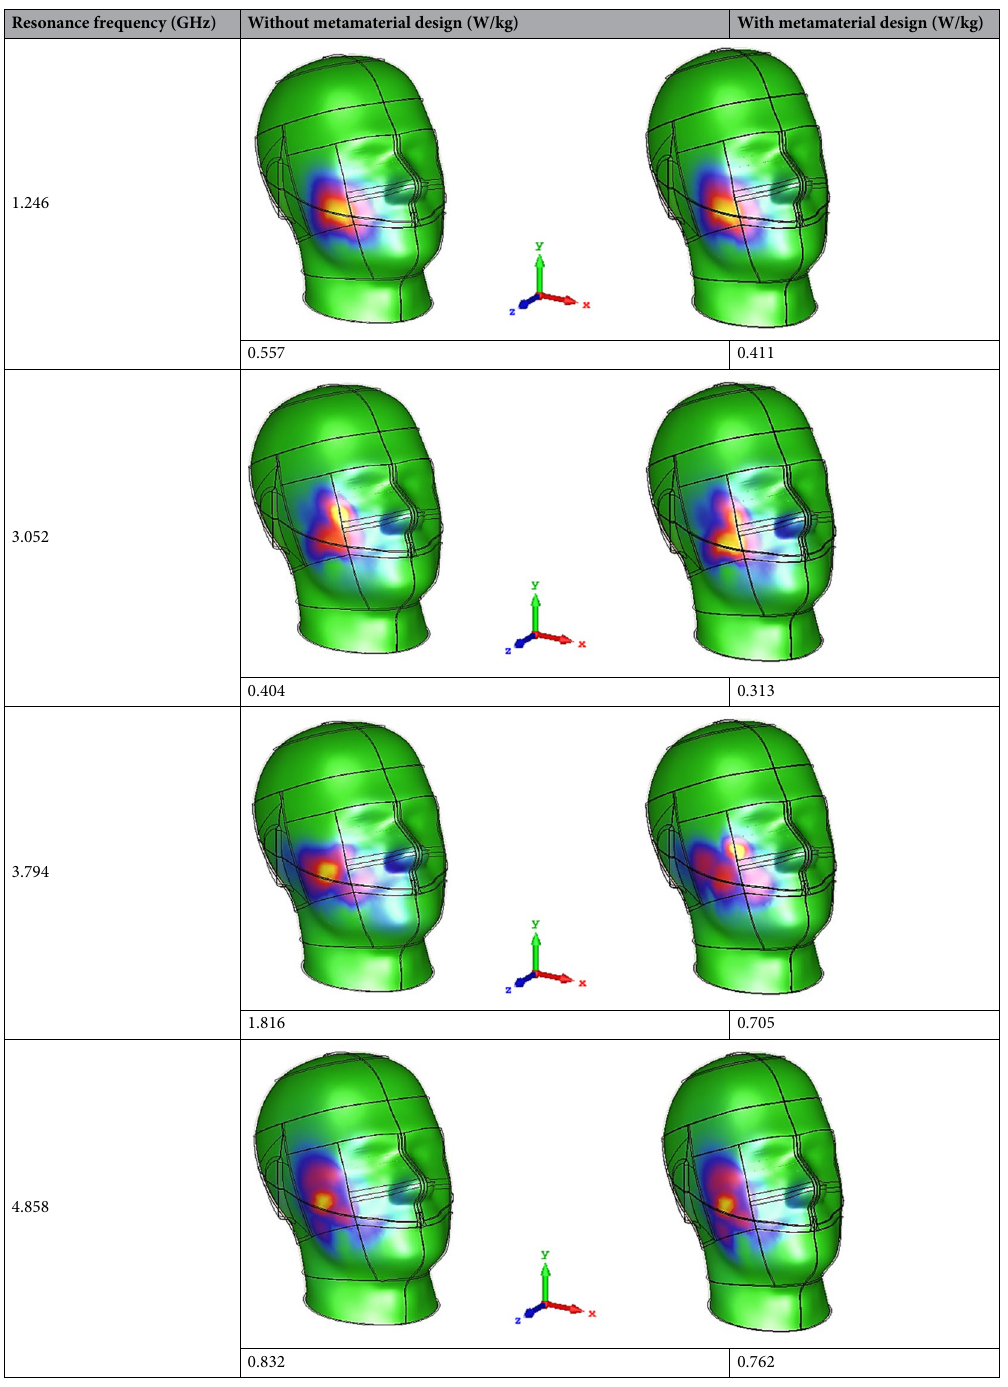
Table 5. SAR reduction values of 1 g of tissue volume with and without proposed metamaterial